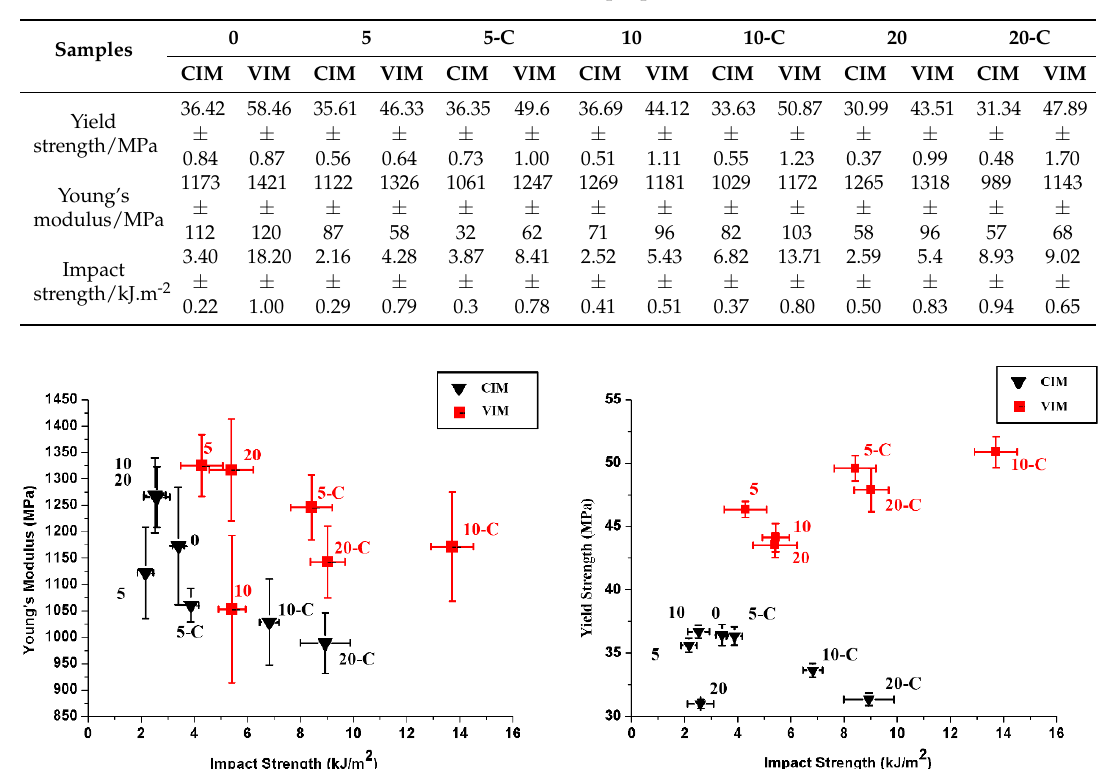
Figure 2. Impact strength VS Young’s modulus ( left ) and Impact strength VS yield strength ( right ).